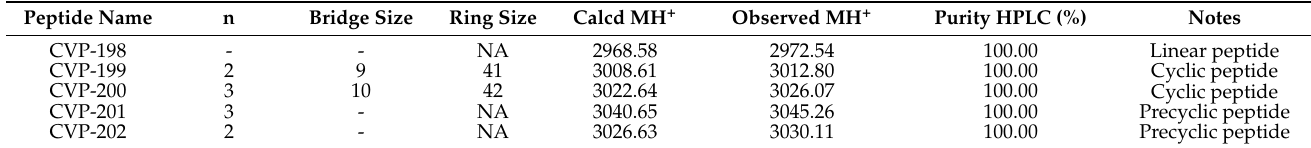
Table 1. Characterization of the developed library.